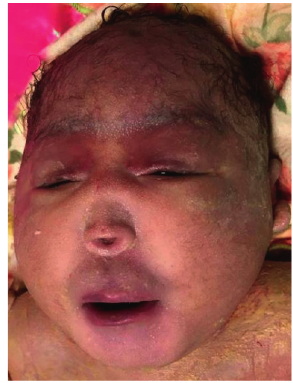
Figure 3: Cebocephaly (monkey-like head).